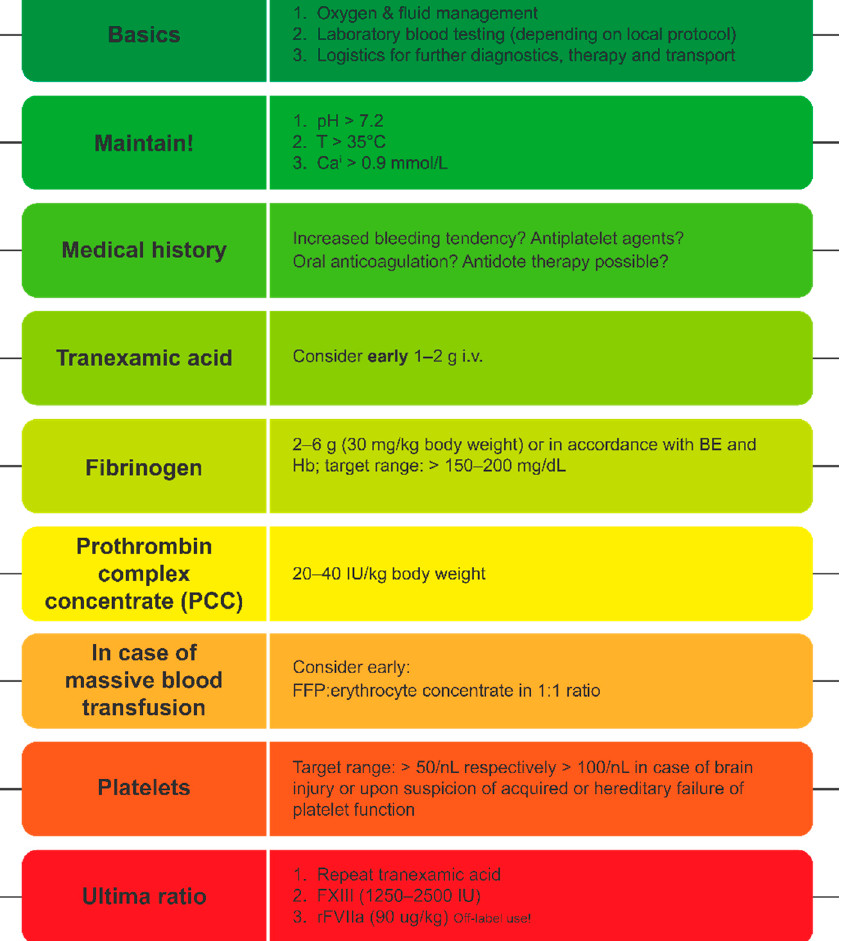
Figure 2. Simplified treatment algorithm for the initial assessment and management of trauma-induced coagulopathy without VET . Adapted from Casu S, 2021 [107]. Reprinted by permission from BMJ as indicated in the Terms and Conditions of the Creative Commons CC-NY license. BE; base excess; Ca, calcium; FFP, fresh frozen plasma; FXIII, factor XIII; Hb, haemoglobin; INR, international normalised ratio; PC, platelet concentrate; pRBC, packed red blood cells; rFVIIa, activated recombinant factor VII; TBI, traumatic brain injury.